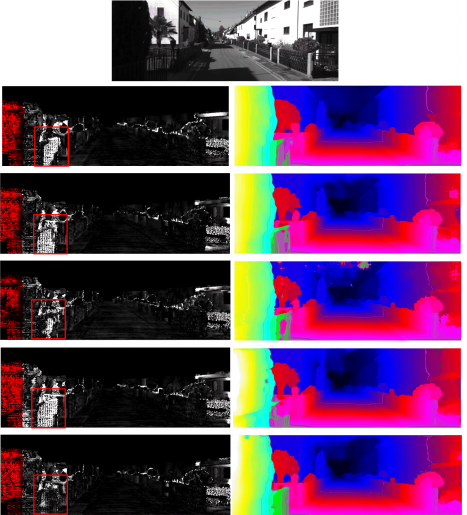
Figure 9. Visualization results on the KITTI2012 dataset. The first line is the original image, and the second, third, fourth, fifth and sixth lines are the error map and disparity map of iResNet-i2, AANet+, GCNet, AANet and our network, respectively. The red box represents a comparison between MCAFNet and other network models.